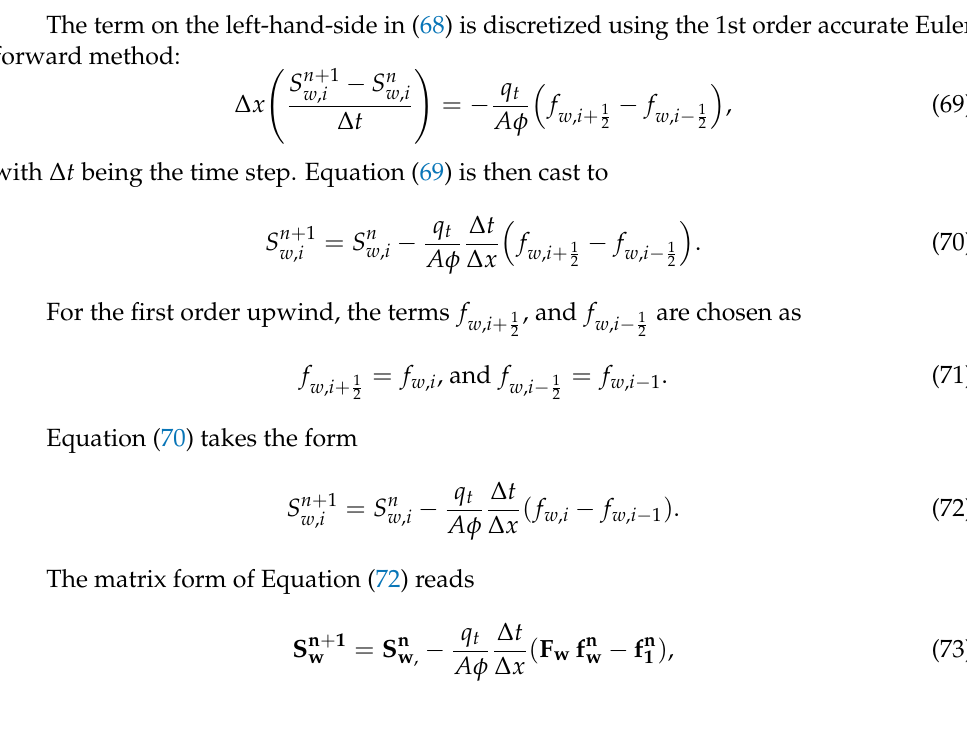
Figure 1. Discretized domain using N + 1 grid